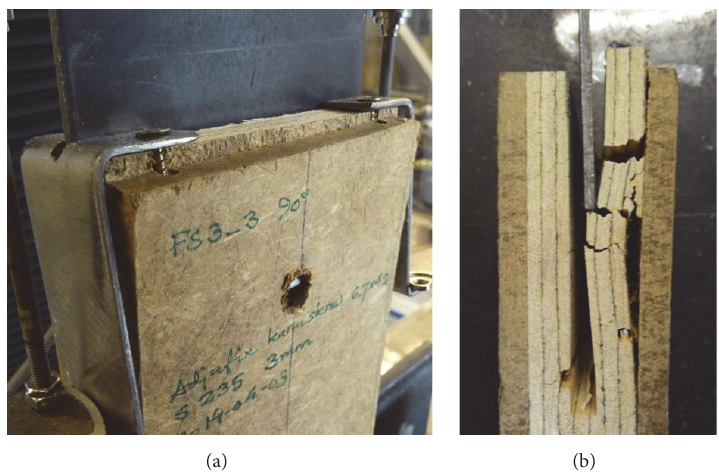
Figure 8: Typical mode of failure for the uplift perpendicular to grain tests, exemplified with specimen number 3: (a) final failure of the LVL at the screw head side (photo taken at a displacement of about 20 mm); (b) edge side showing multiple tensile and shear crack formations.